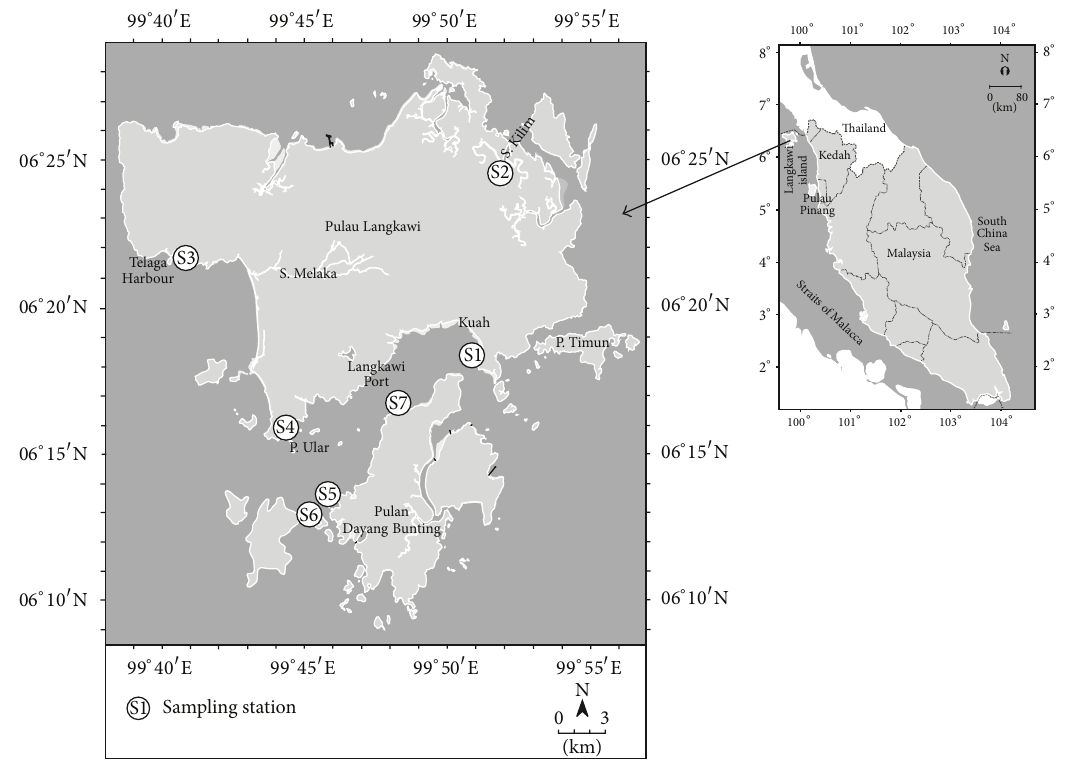
Figure 1: Map showing the seven sampling stations (S1–S7) around Langkawi Island,